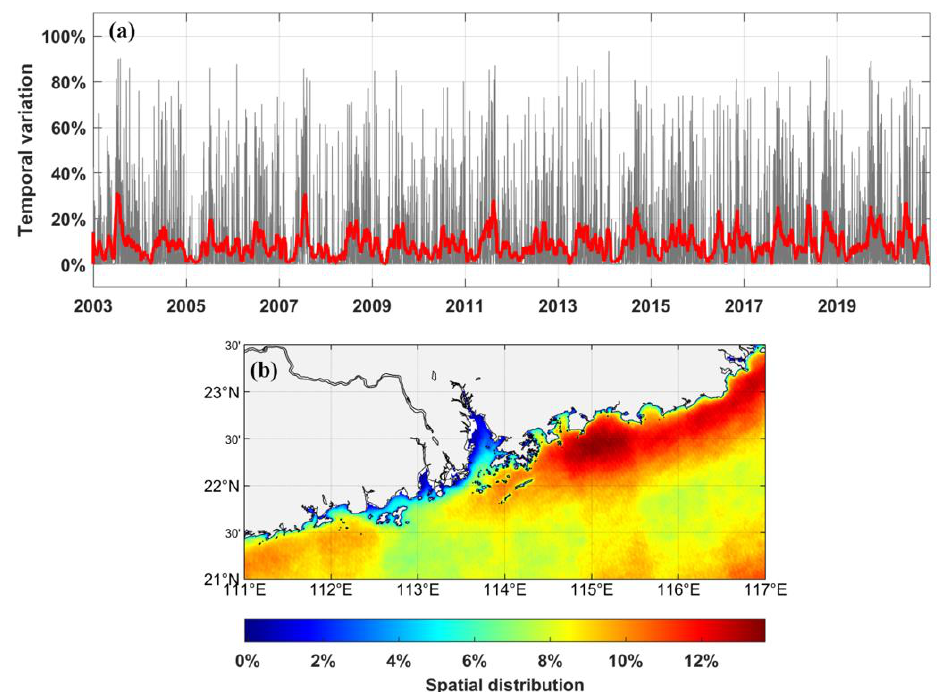
Figure 5. ( a ) Temporal variability of non-missing data coverage percentage and with low-pass filter of one month (red line); ( b ) mean percentage of non-missing data coverage.